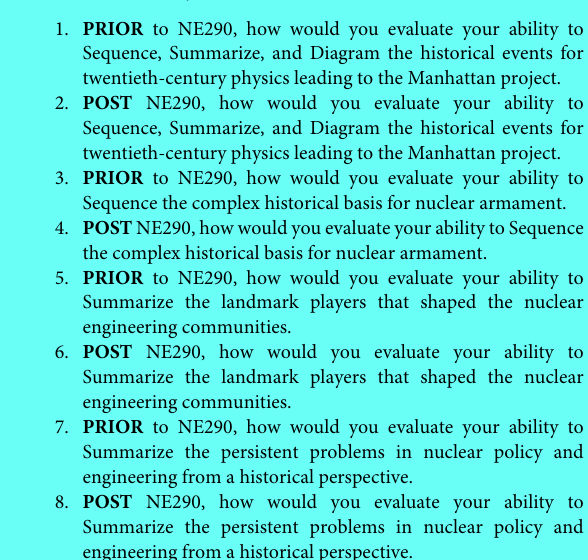
of 11 students (2 female and 9 male). In terms of